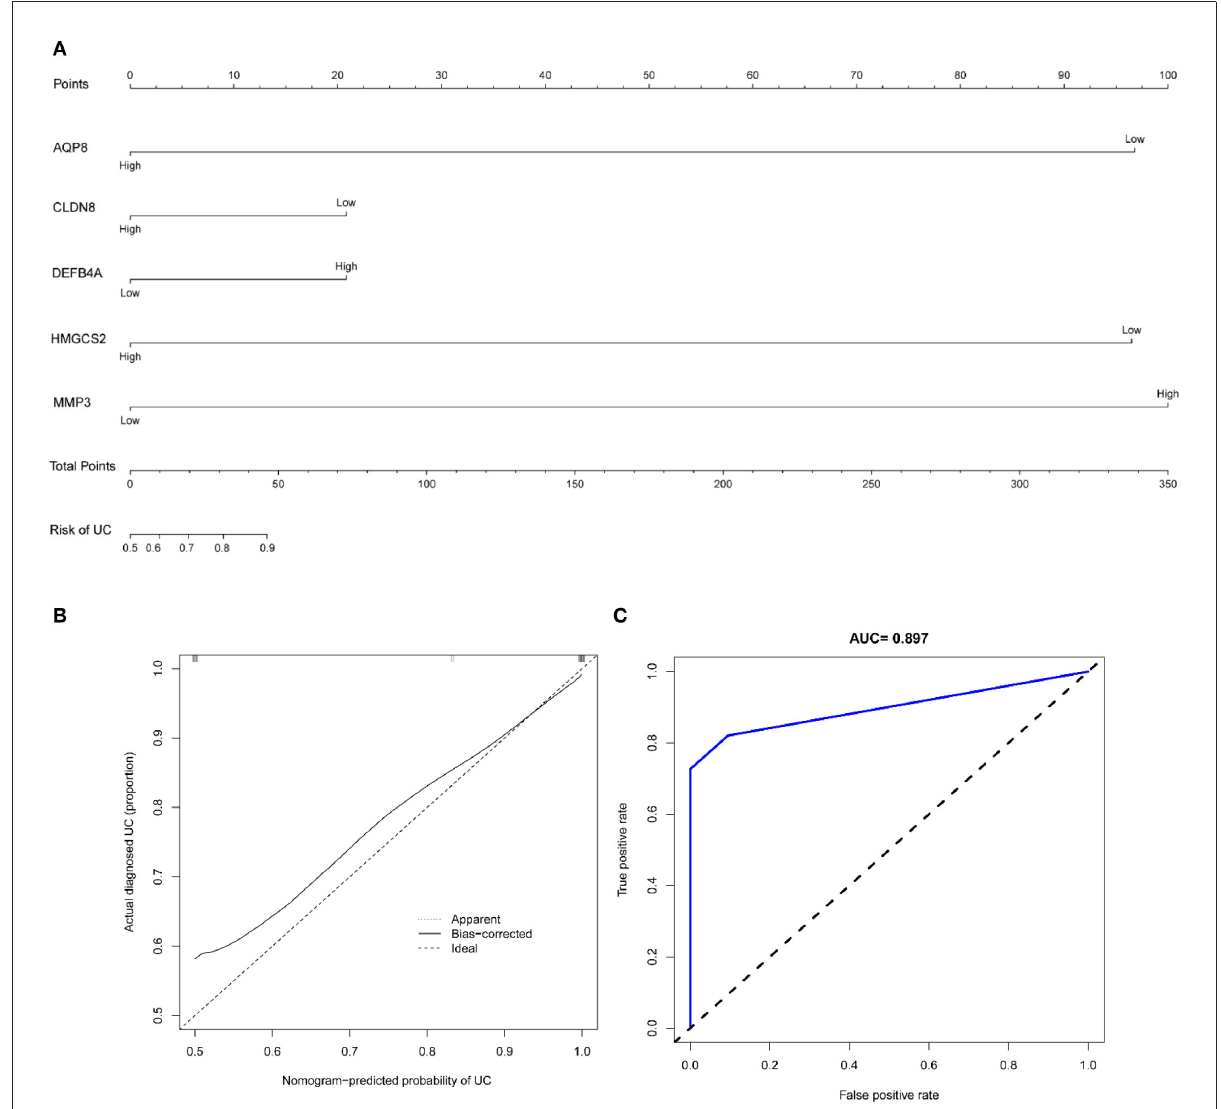
FIGURE9 (A) Nomogram of diagnostic marker genes; (B) calibration curve of non-correlation nomogram prediction in the cohort; (C) ROC curve for the diagnostic efficacy of diagnostic